Question: Looking at the figure, what chart type is it?
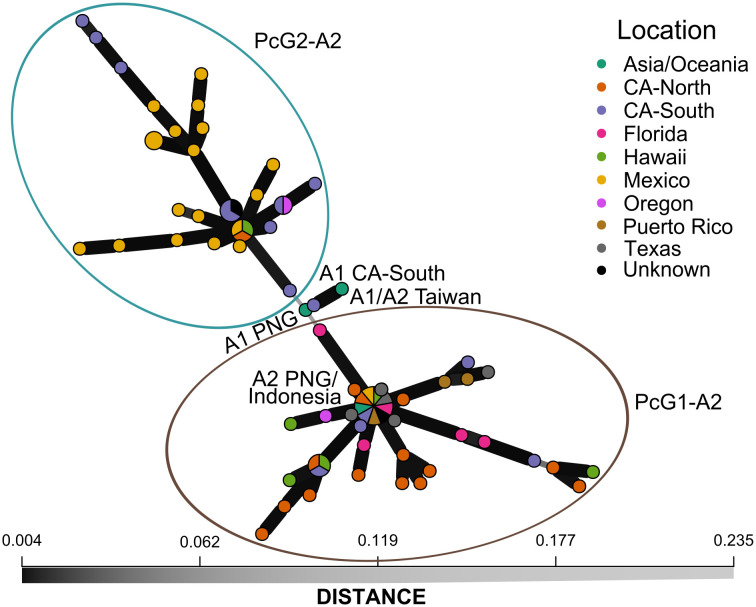
Answer: pie